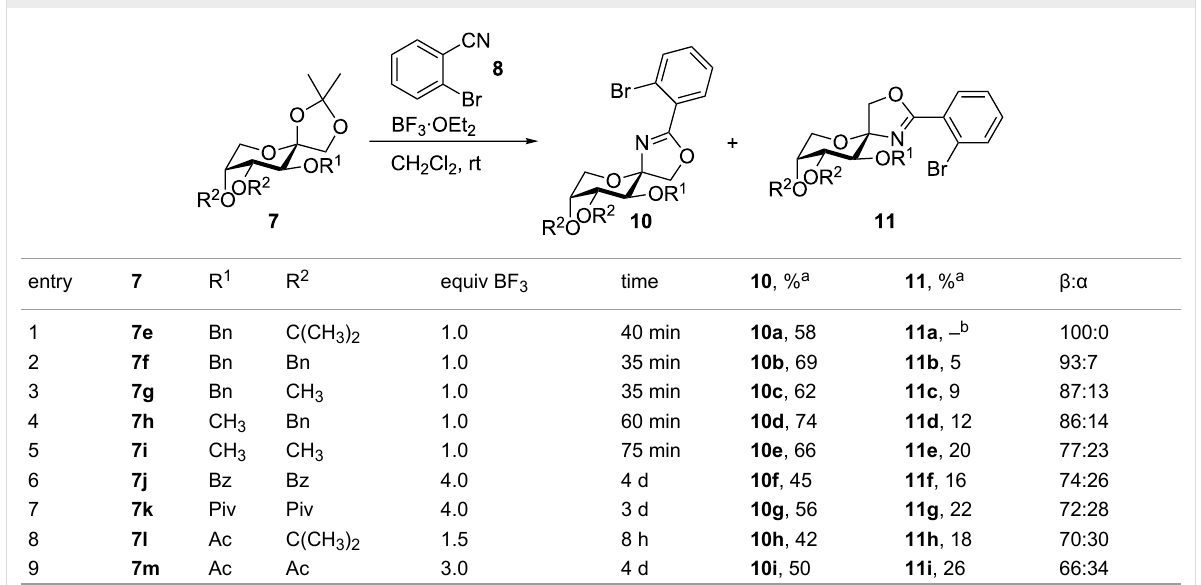
Table 1: Synthesis of spiro-fused oxazolines 10 and 11 via Ritter